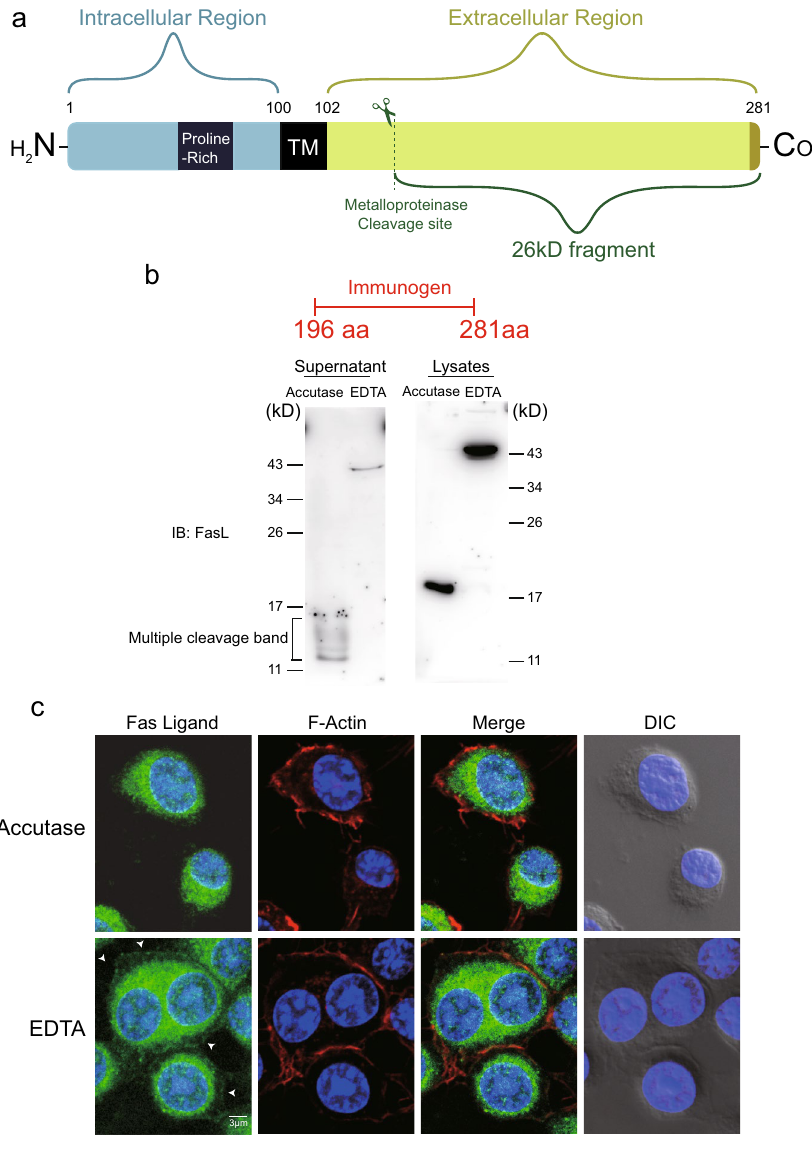
Figure 3. Accutase cleaved surface FasL proteins. ( a , b ) RAW264.7 cells were incubated with either accutase or EDTA cell detachment buffer for 30 min. The supernatants and lysates in both groups were collected and concentrated. The FasL proteins in the supernatant and lysates were analyzed by western blot. Specific antibodies against the extracellular domain of FasL were used for protein detection. ( b ) RAW264.7 cells were incubated with either accutase or EDTA cell detachment buffer for 30 min, followed by immunofluorescence staining. The white arrows indicate the FasL proteins around cell